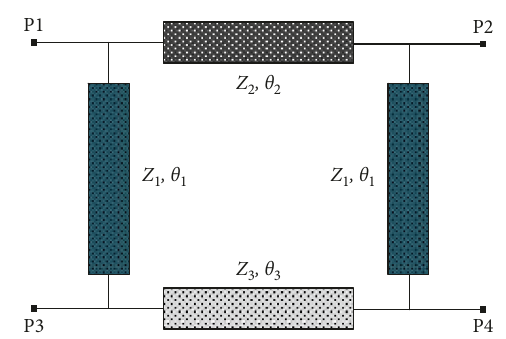
Figure 3: Arbitrary phase-difference hybrid coupler. Table 1: Phase response of the butler